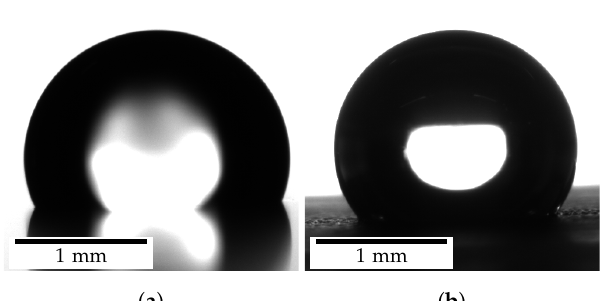
Figure 8. Images of water droplets on MAE surfaces as recorded by the measurement setup. ( a ) Droplet on reflective MAE surface outside magnetic field; reflection and contact line are clearly visible. ( b ) Droplet on matt MAE surface inside magnetic field; no reflection is visible and the contact line is difficult to